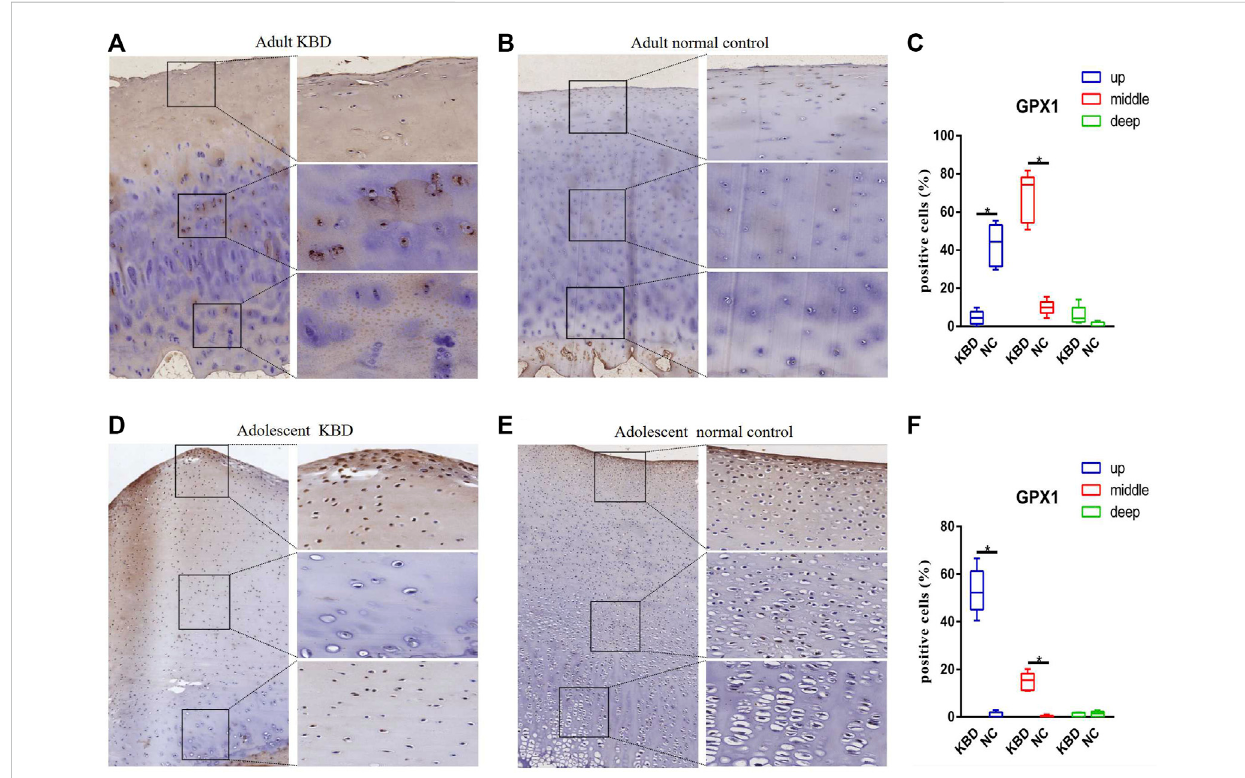
FIGURE 2 Representative immunohistochemistry staining of GPX1 in adult KBD (A) , adult normal control (B) , adolescent KBD (D) , and adolescent normal control (E) cartilagetissues(scalebar:left,500 μ m;right,100 μ m)andcomparativequanti fi cationofpositivecellsofdifferentareas(up,middle,anddeep) in adult (C) and adolescent (F) cartilage tissues displayed by a box plot (n = 3). * p <